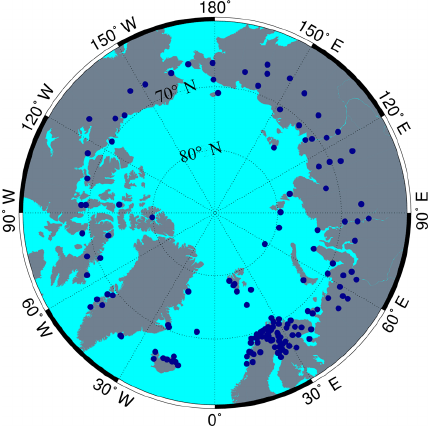
Figure 3. SYNOP network coverage over the Arctic, the dark-blue points indicate the location of SYNOP stations.